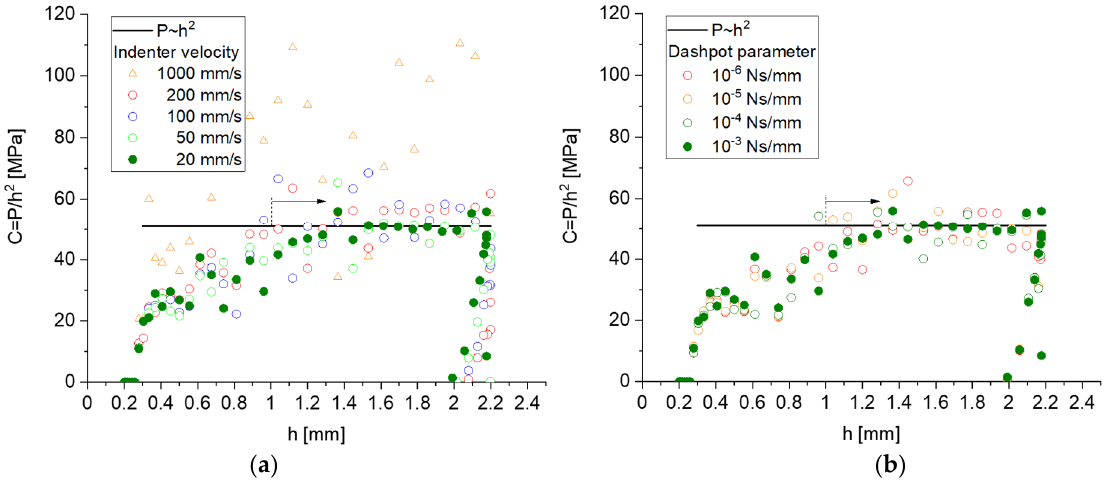
Figure 4. Parametric study for adjustment of ( a ) indenter velocity with smooth step function for a dashpot parameter of 10 − 3 Ns/mm and ( b ) dashpot parameter at fixed indenter velocity of 20